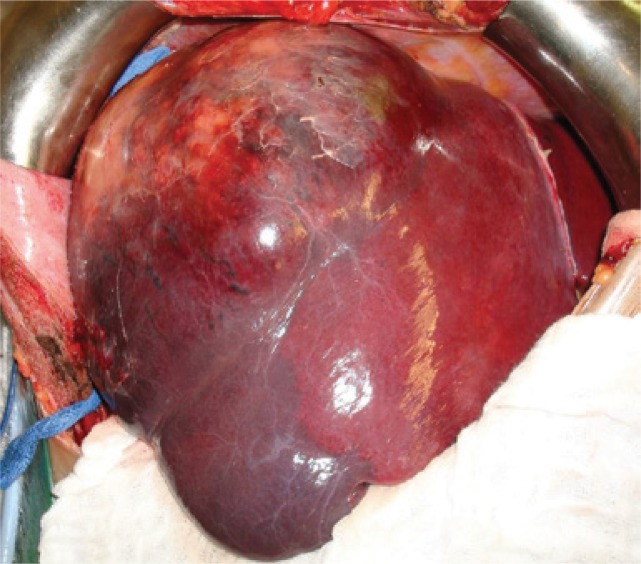
Fígado com lesão extensa acometendo lobo hepático direito